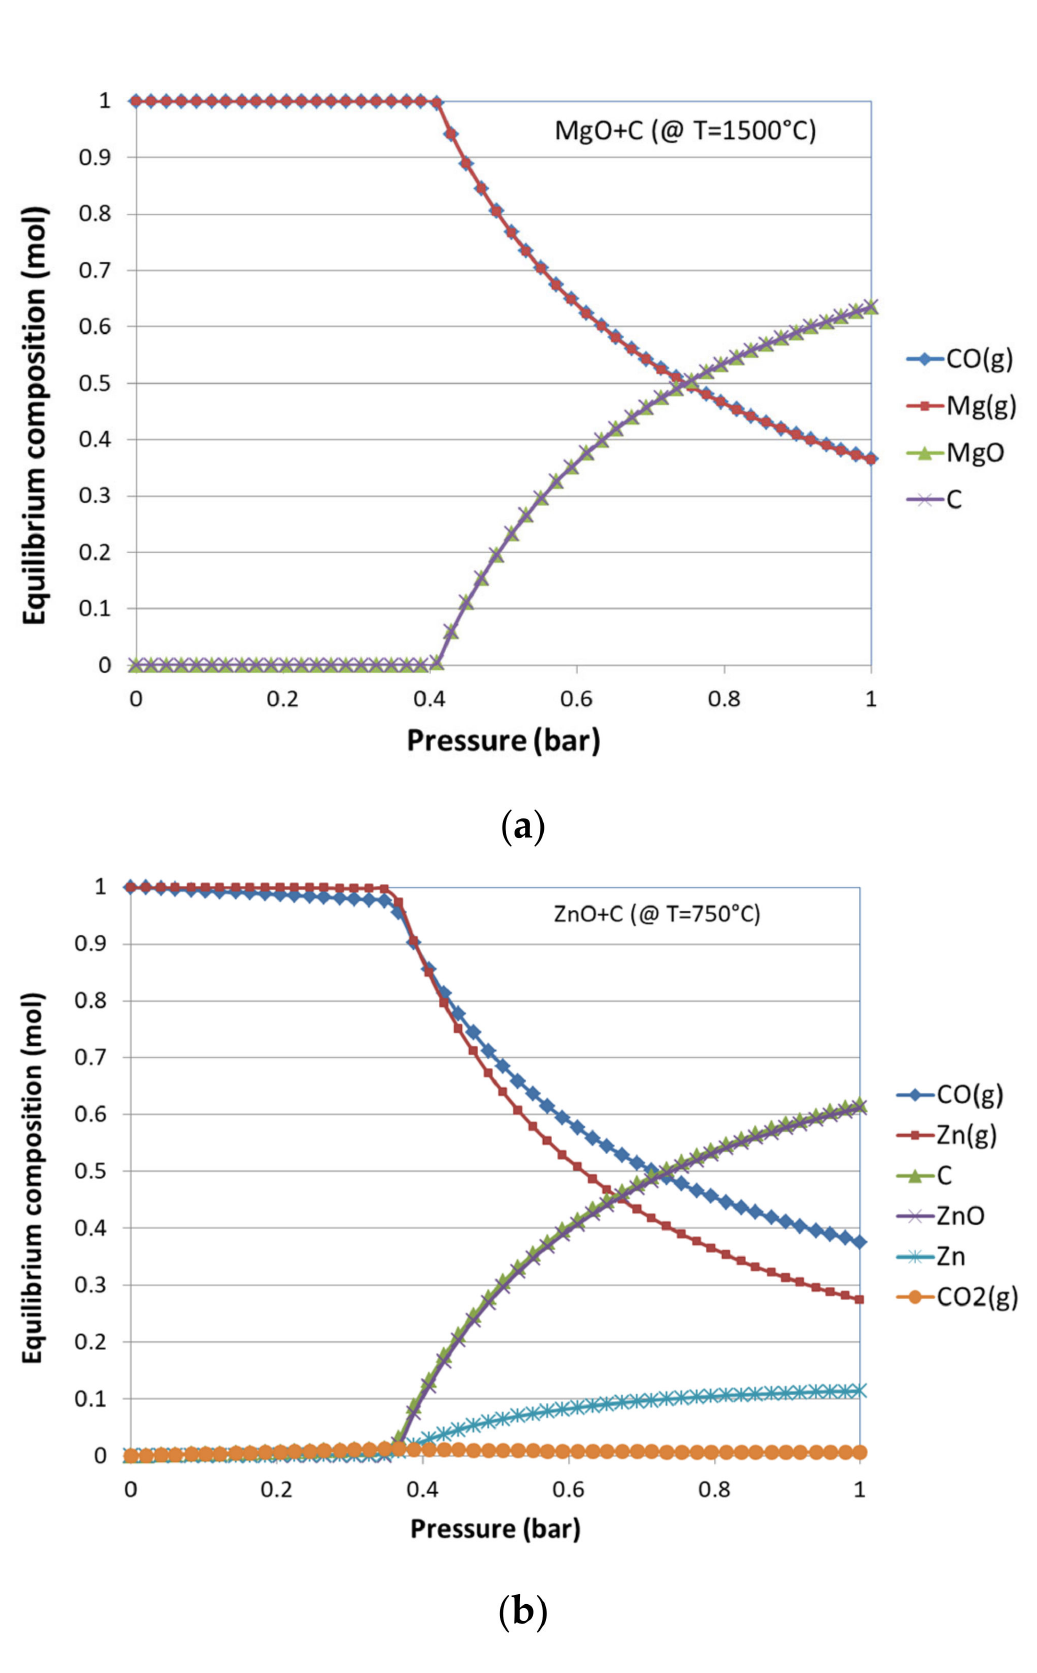
Figure 3. Influence of total pressure on equilibrium product distribution for the carbo-thermal reduction of ( a ) MgO (at 1500 ◦ C) and ( b ) ZnO (at 750 ◦